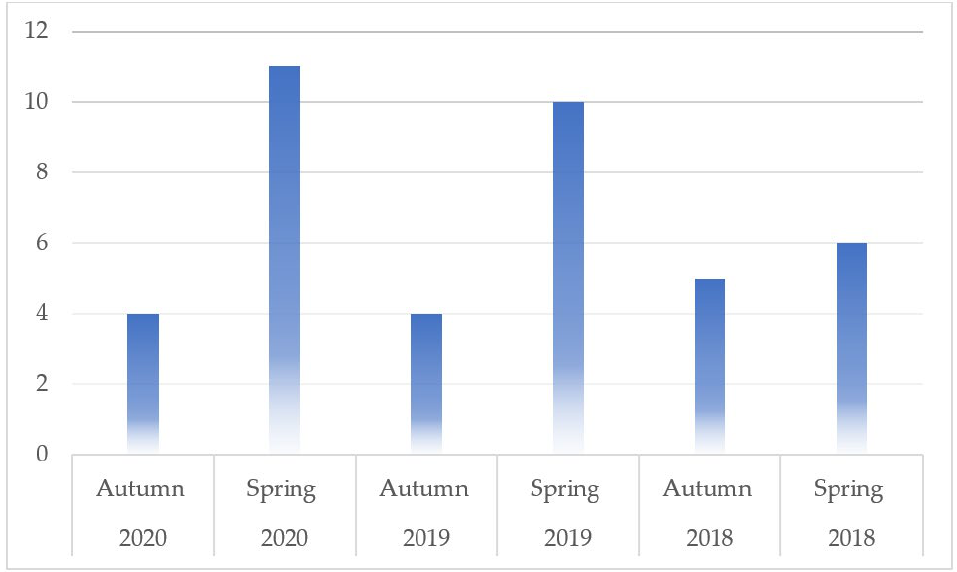
Figure 2. Each bar displays the number of nutrition-related multiple-choice questions in the respec- tive exam. exam.